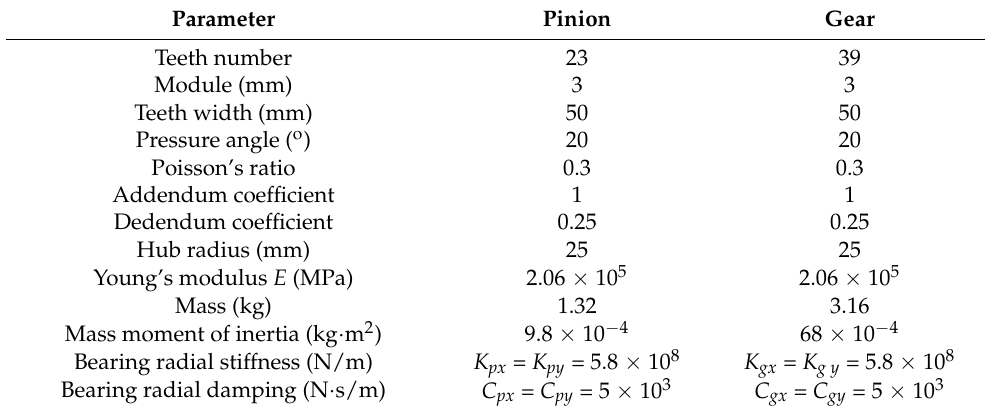
Table 1. Spur gear system parameters.